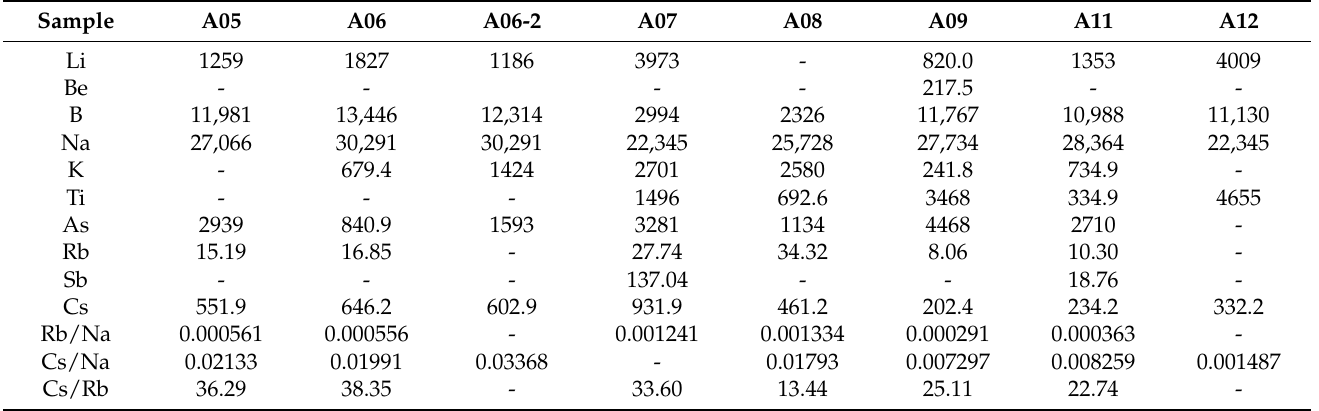
Table 3. LA-ICP-MS in situ analysis of fluid inclusions in rose quartz of Dakalasu No. 1 pegmatite vein (ppm).